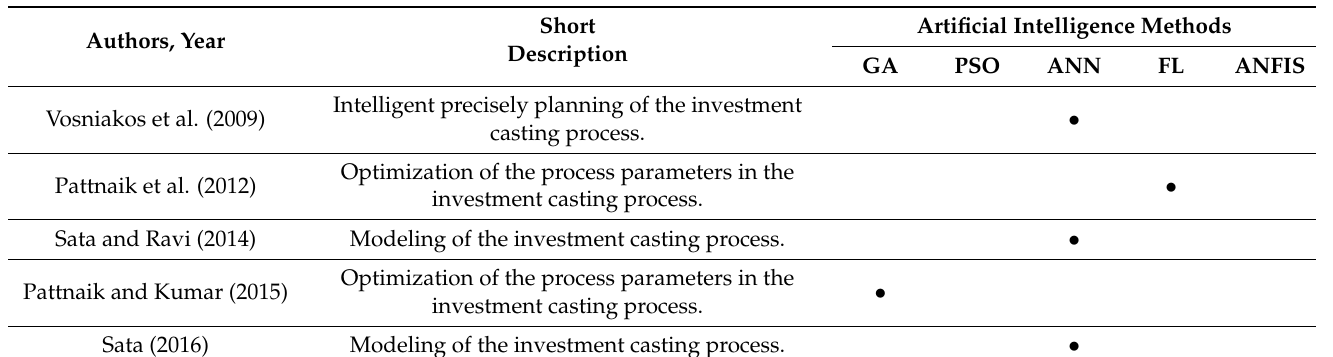
Table 4. Artificial intelligence methods used to improve the investment casting